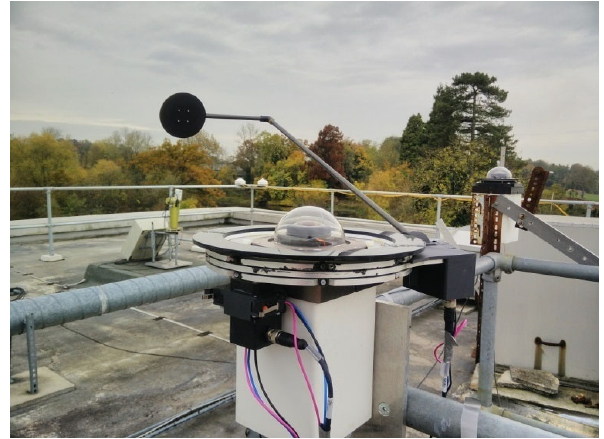
Figure 1. All-sky daytime camera with occulting disk in operation in the foreground. The night-time camera is in the background and on the